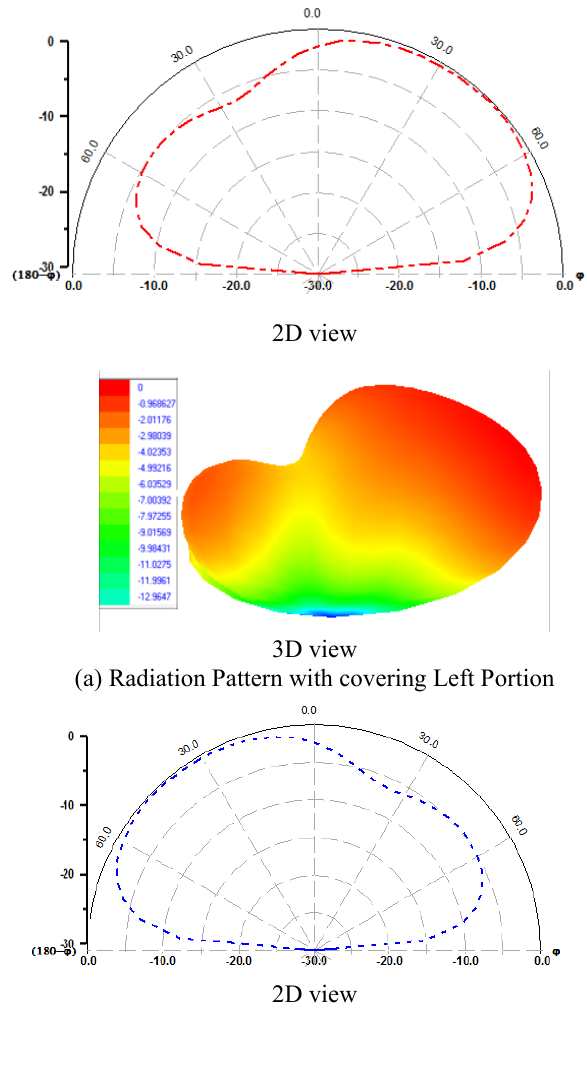
Figure 10. Radiation pattern of the suggested steerable